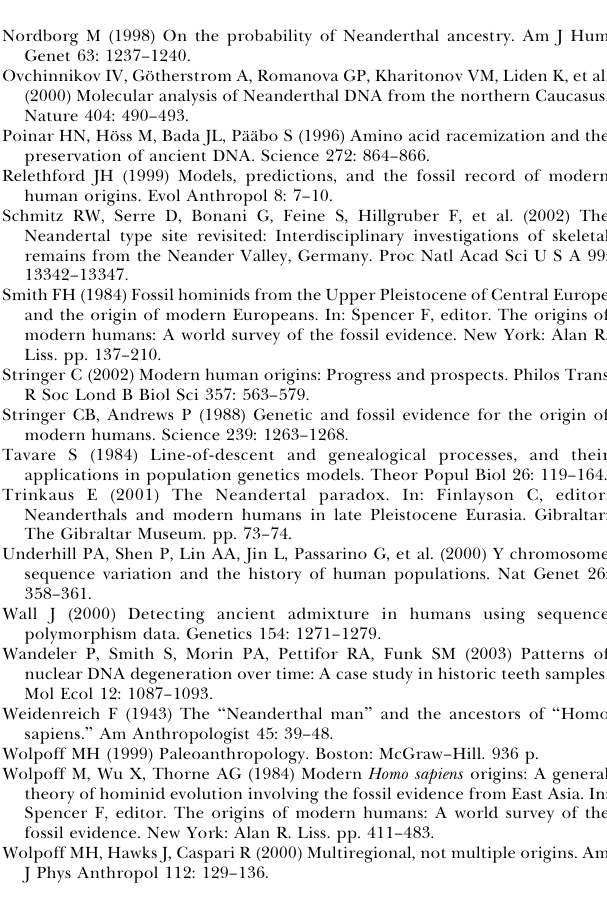
Figure S1. The DNA Sequences of the Clones Used to Reconstruct the Sequence of the Mitochondrial Hypervariable Region I from the Bone Vi-80 Found at DOI: 10.1371/journal.pbio.0020057.sg001 (30 KB PDF). Figure S2. Expected Number of Ancestors E(A n ( t )) of n Individuals under a Model of Constant Population Size of Ne = 10,000 The number of ancestors of n individuals (x axis) is estimated at 20,000, 25,000, and 30,000 years ago. For example, 150 humans living today have approximately seven ancestors 20,000 years ago. Figure S3. Probability of Different Levels of Admixture